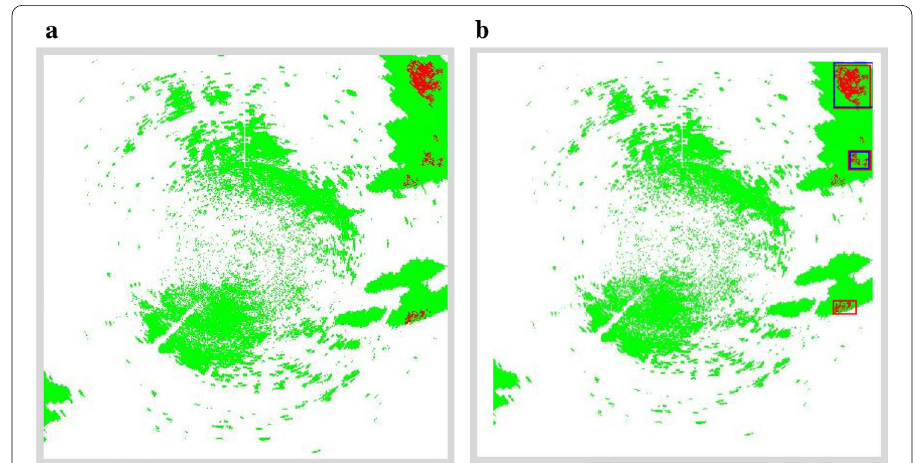
Fig. 14 The identification result of precipitation clouds corresponding to 2342UTC. a Traditional method, b